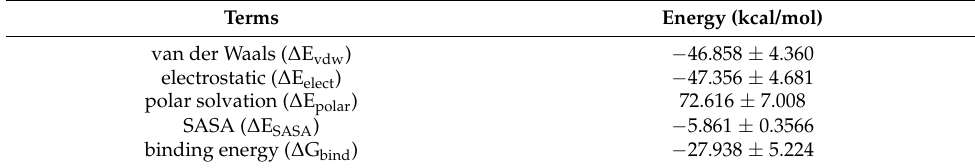
Table 3. Molecular energetic terms of interactions between PGG and STAT3